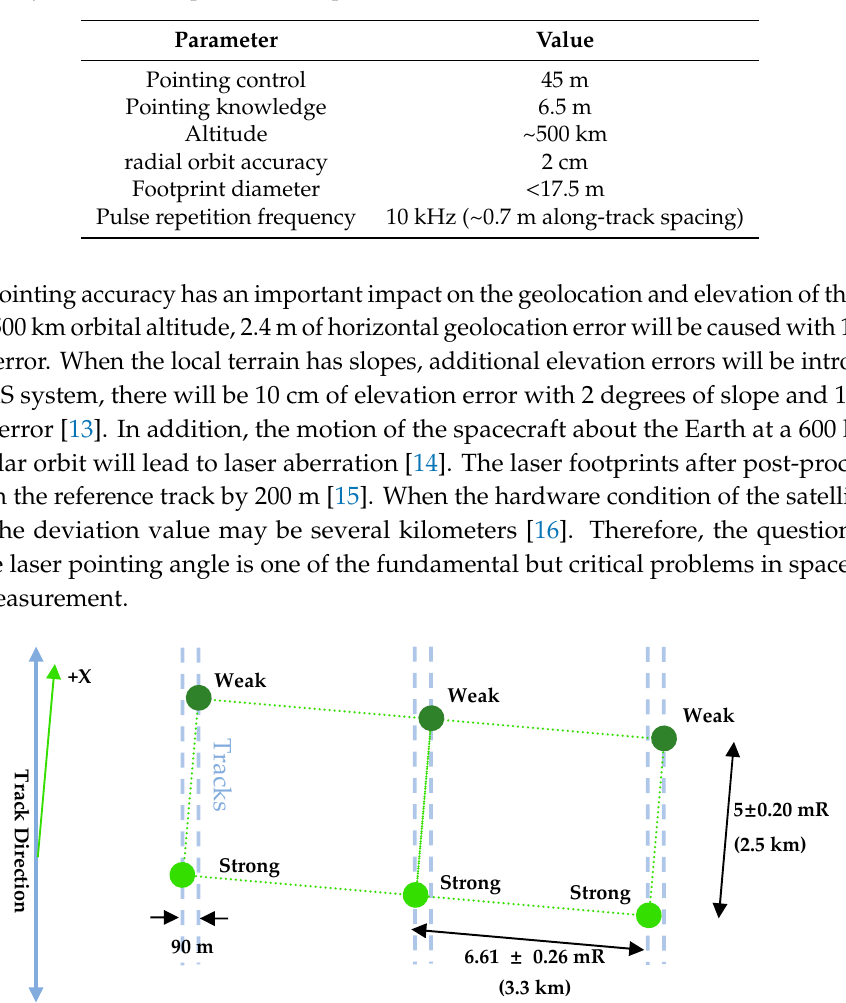
Table 1. Key Ice, Cloud and Land Elevation Satellite-2 (ICESat-2)/Advanced Topographic Laser Altimeter System (ATLAS) performance specifications.